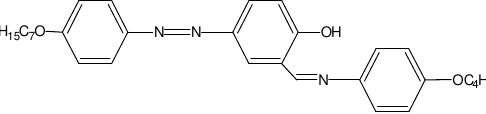
Figure 1 . Structure of